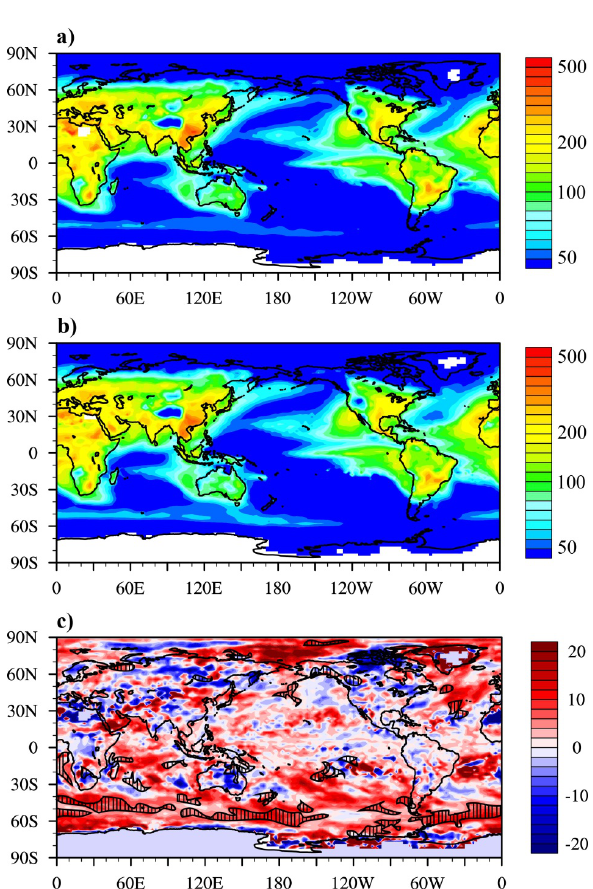
Fig. 1. Model predicted the 10-yr average in-cloud droplet number concentration (cm − 3 ) from 940–985mb for the ( a) Default and ( b) Figure 1. Model predicted the 10 ‐ year average in ‐ cloud droplet number concentration (cm ‐ 3 ) from 940 ‐ 985 mbfor G11 simulations and the ( c) percentage (%) change between the two the a) Default and b) G11 simulations and the c) percentage(%) change between the two simulations. Striped simulations. Striped areas in Fig. 1c have 10 or more contiguous areas in Fig. 1c have 10 or more contiguous model grids with significant ( p ‐ value of paired t ‐ test < 0.1) differences model grids with significant ( p -value of paired t-test < 0.1) differ- between the G11 and Default simulations. ences between the G11 and Default